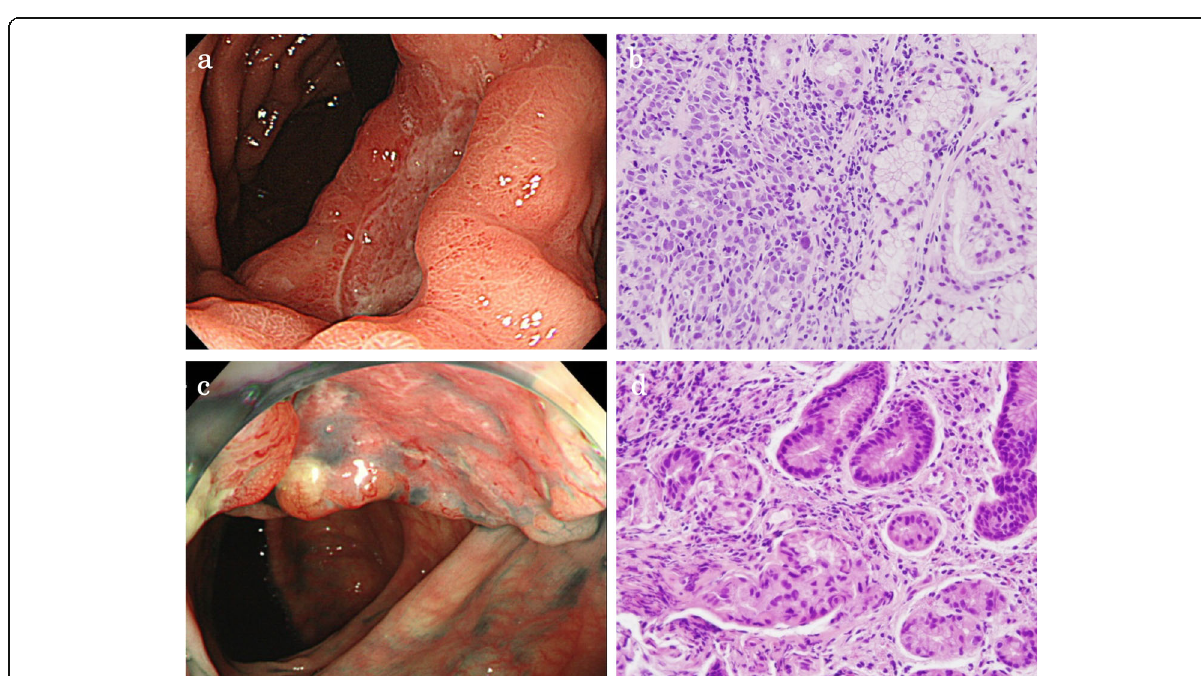
Fig. 1 Imaging findings before chemotherapy. a Gastroscopy showed a type II tumor at the lesser curvature of the gastric body. b Pathological findings indicated poorly differentiated adenocarcinoma. c Colonoscopy showed a type II tumor with a diameter of 25 mm in the transverse colon. d Pathological findings indicated well-differentiated tubular adenocarcinoma